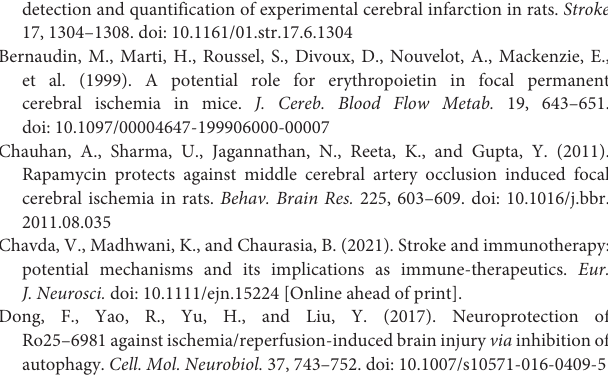
SUPPLEMENTARY FIGURE 1 | Effect of eriodictyol on blood flow in MCAO